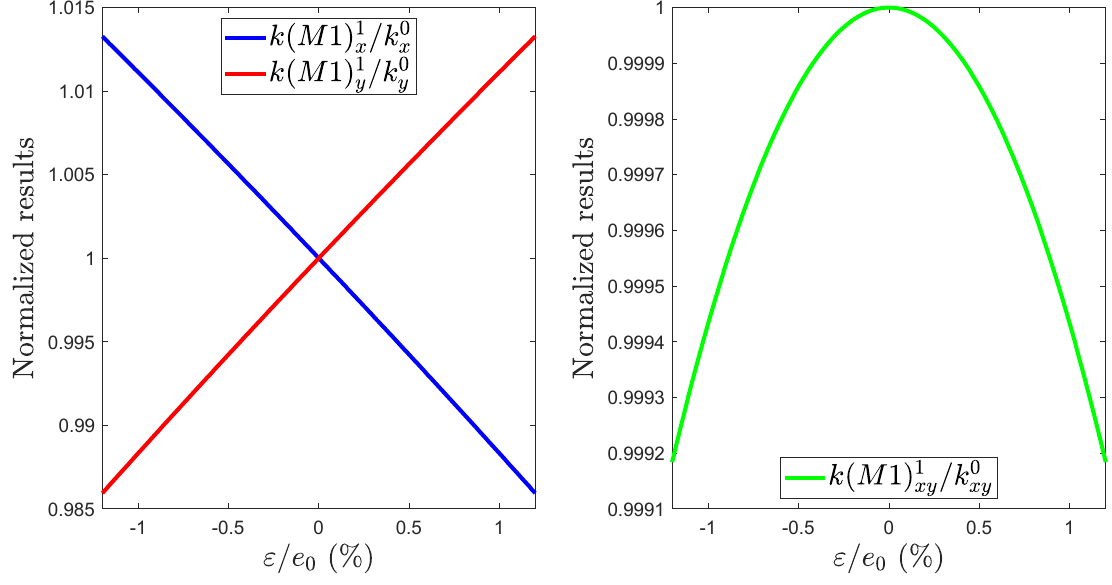
Figure 5. Normalized 𝑘(𝑀1) (cid:3051)(cid:2869) , 𝑘(𝑀1) (cid:3052)(cid:2869) and 𝑘(𝑀1) (cid:3051)(cid:3052)(cid:2869) values as a function of the width variation.